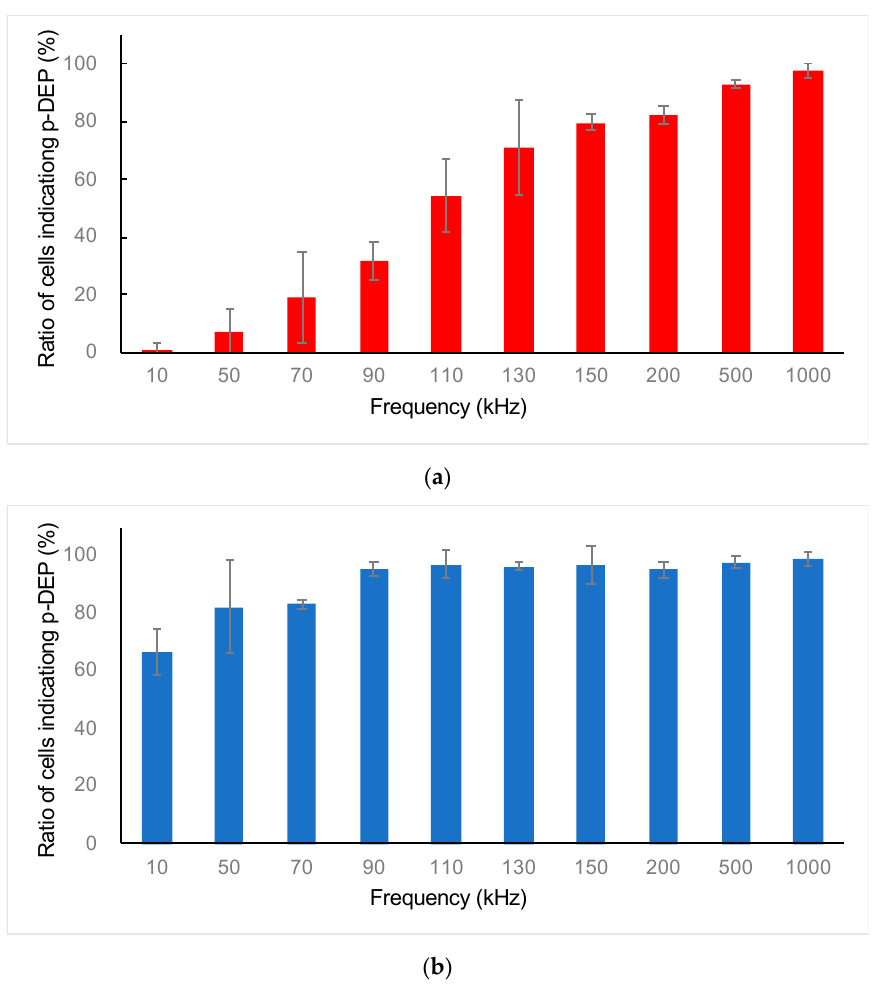
Figure 7. Ratio of ( a ) ES-B3 and ( b ) MEF cells indicating positive dielectrophoresis according to the frequencies of the applied AC electric field.